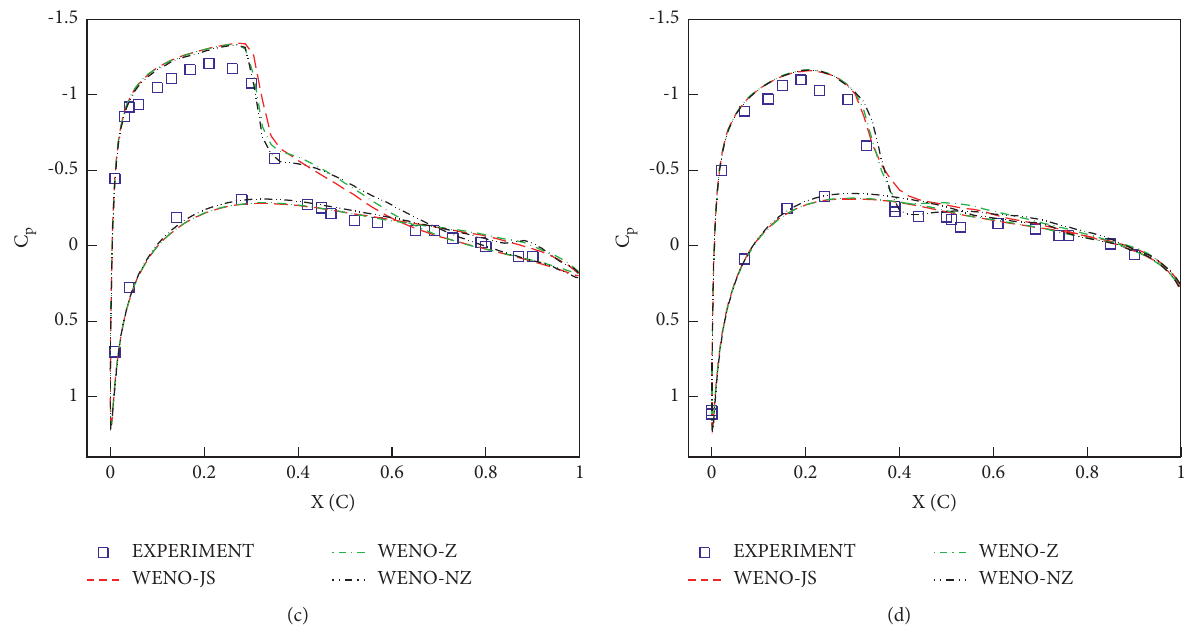
Figure 17: Pressure coefficients at the blade surface about the transonic flow over the Caradonna-Tung rotor.